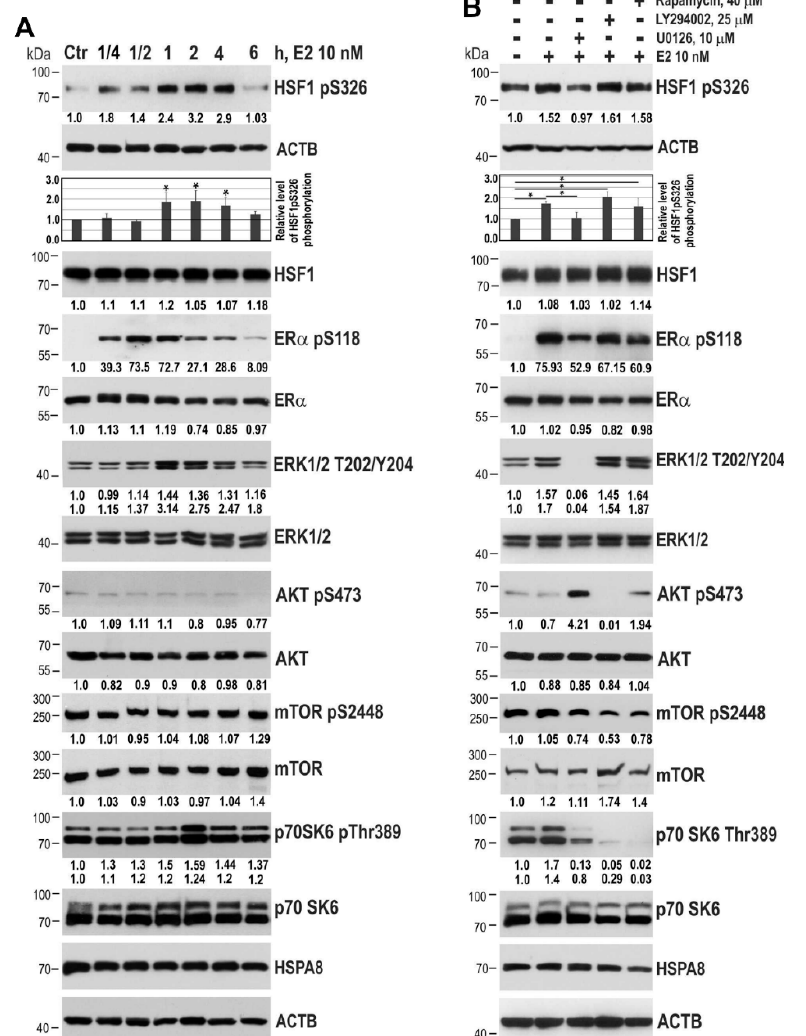
Figure 3. ERK1/2 and mTOR are involved in E2-induced HSF1 phosphorylation in MCF7 cells. Western blot analyses: ( A ) The time-course analysis of HSF1 phosphorylation on S326, ER α on S118, ERK1/2 on T202/Y204, AKT on S473, mTOR on S2448 and p70S6K on T389 in cells treated with 10 nM E2. ( B ) HSF1 phosphorylation on S326 in cells treated with E2 for one hour alone or pretreated with 10 µM U0126 (MEK1/2/ERK1/2 signaling inhibitor), 25 µM LY294002 (PI3K/AKT signaling inhibitor)